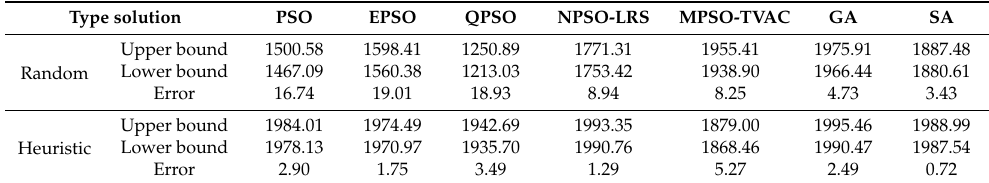
Table 4. Error for confidence interval